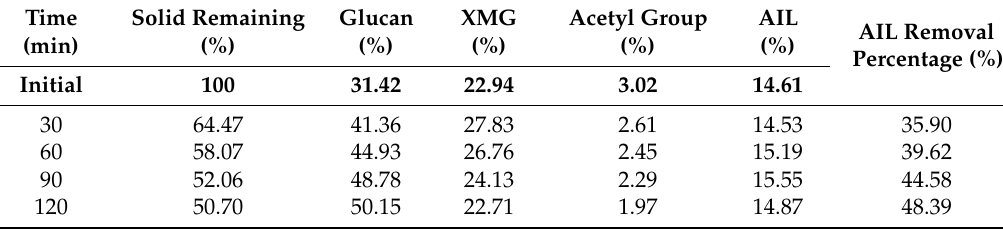
Table 4. Change in composition of wheat straw after the combined ball mill and organosolv pretreatment performed at 170 ◦ C with 50 rpm